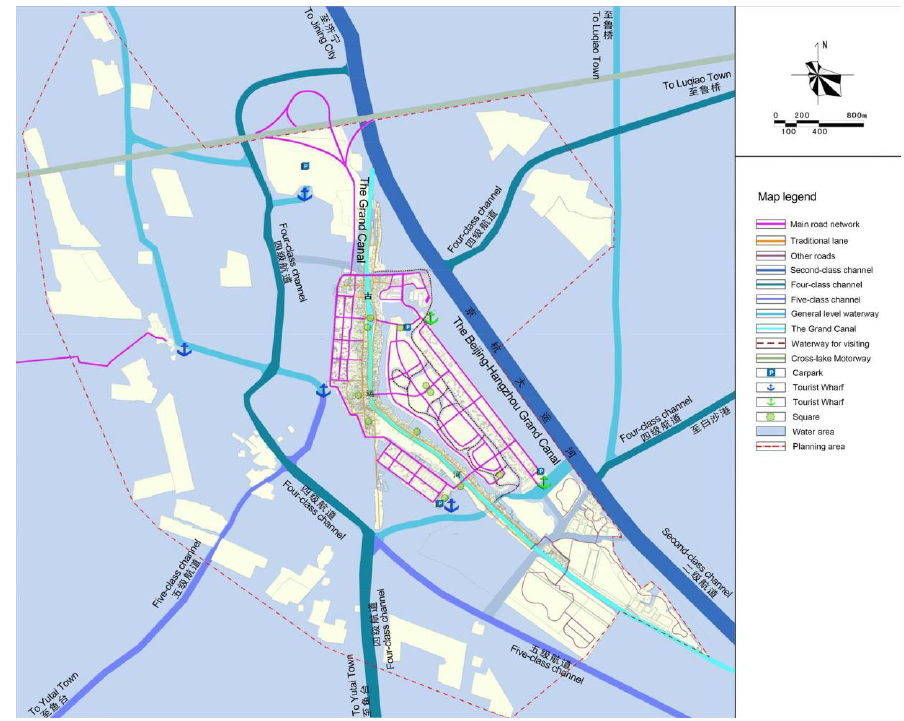
Figure 1. Road-network waterway system plan in Nanyang (Source: Nanyang Government).